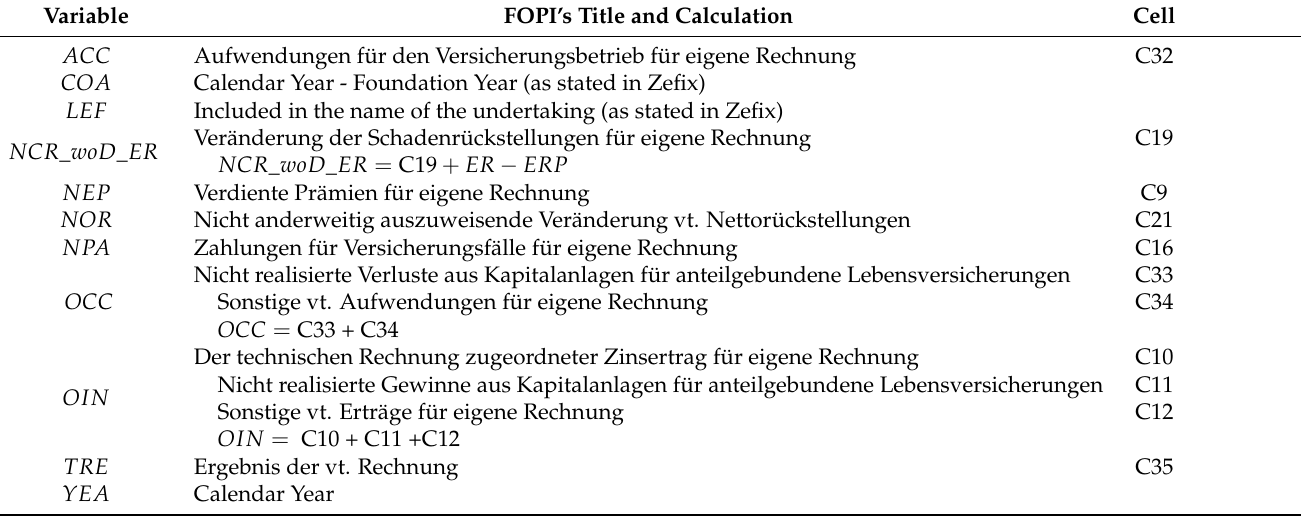
Table A1. FOPI published the files “Jahresrechnungen” in each calendar year for each undertaking. This is the source of the available explanatory variables for reinsurance and non-life undertakings.